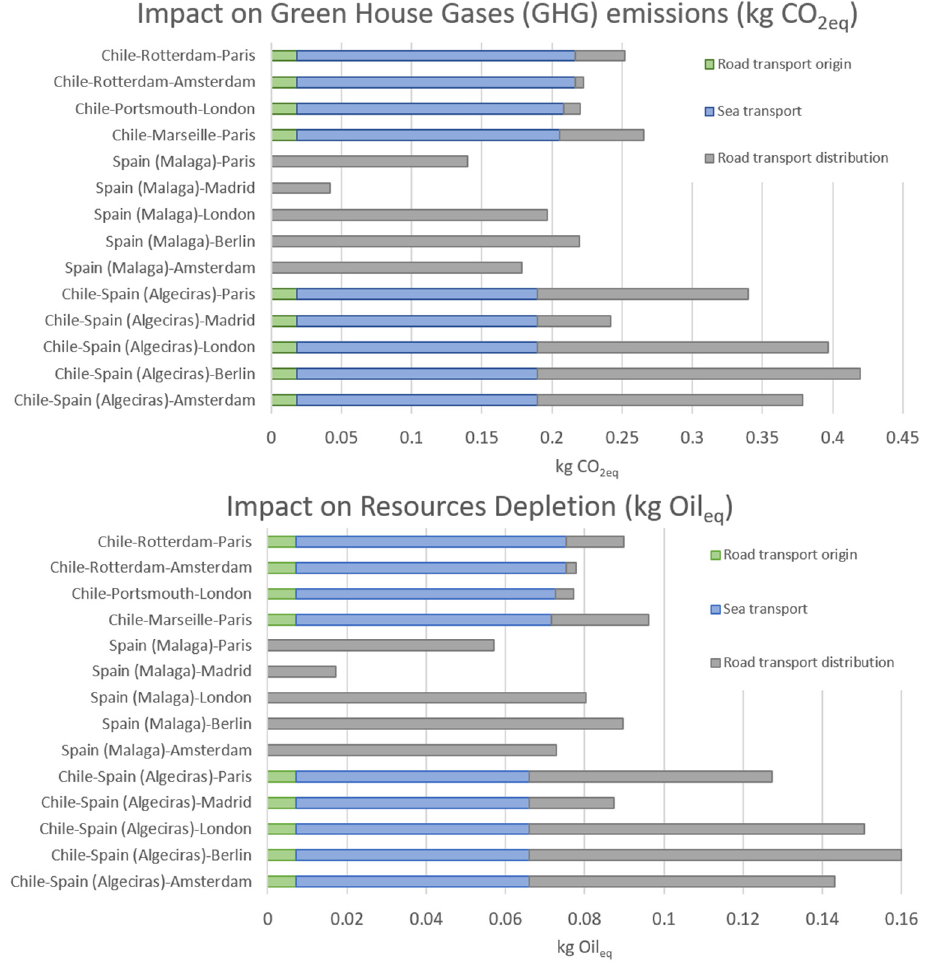
Figure 1. Impacts on two midpoint categories of different options for the transport of 1 kg of avocados, indicating the contribution of the three parts of the total trip: road transport at origin (green), oceanic freight (blue), and final road transport to distribution markets in Europe (grey). The two categories presented are Green House Gases (GHG) emissions (kg CO 2 eq) and Resources Depletion (kg Oileq). and sea transport) of the freight are indicated by different colors in the stacked